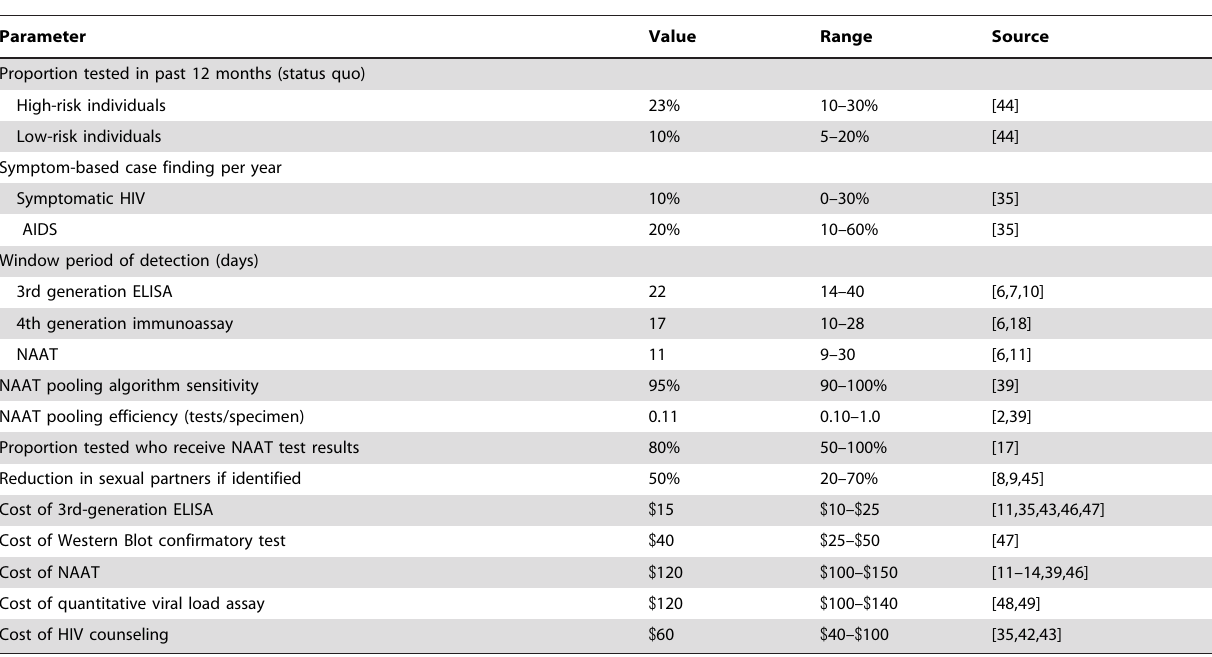
Table 1. Key HIV screening